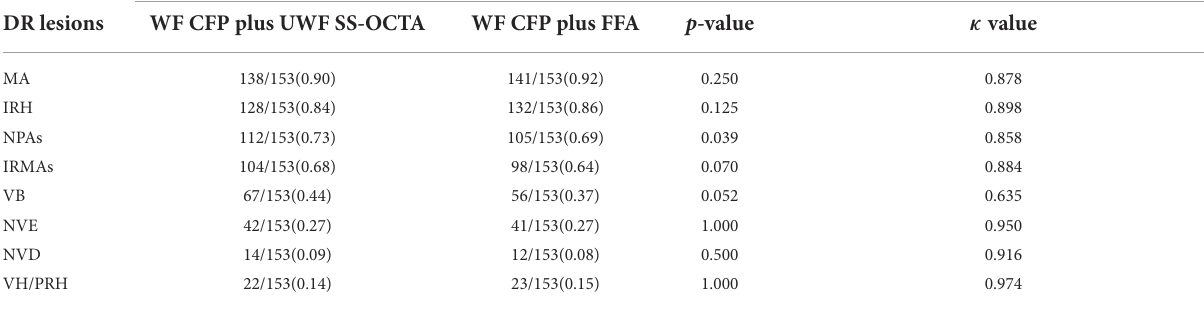
TABLE 3 Detection rate of DR lesions on WF CFP plus UWF SS-OCTA vs. WF CFP plus FFA.